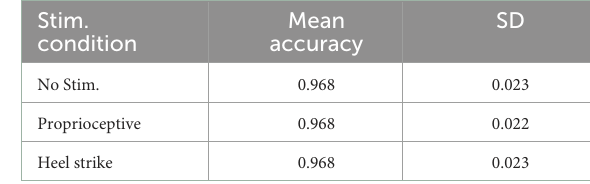
TABLE 1 Accuracies for each of the BD-BCI stimulator stimulation modes in the phantom brain experiment. Stim. condition